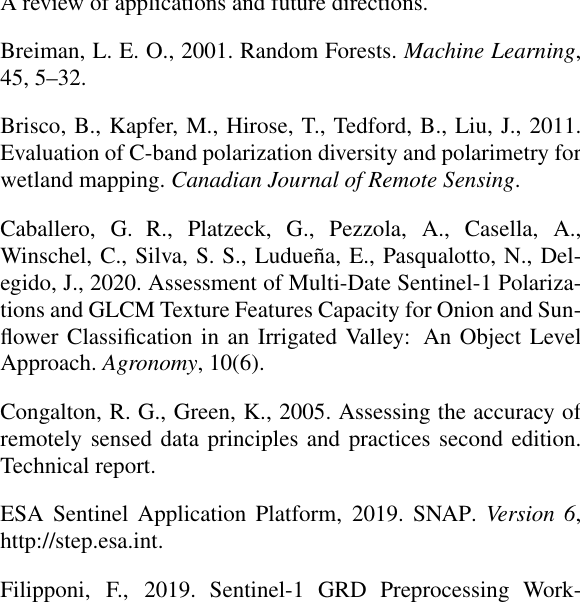
Table 2. Kappa Index Values ( κ ) and Overall Accuracy (OA) obtained for Random Forest classifier in different scenarios. Best result indicated in